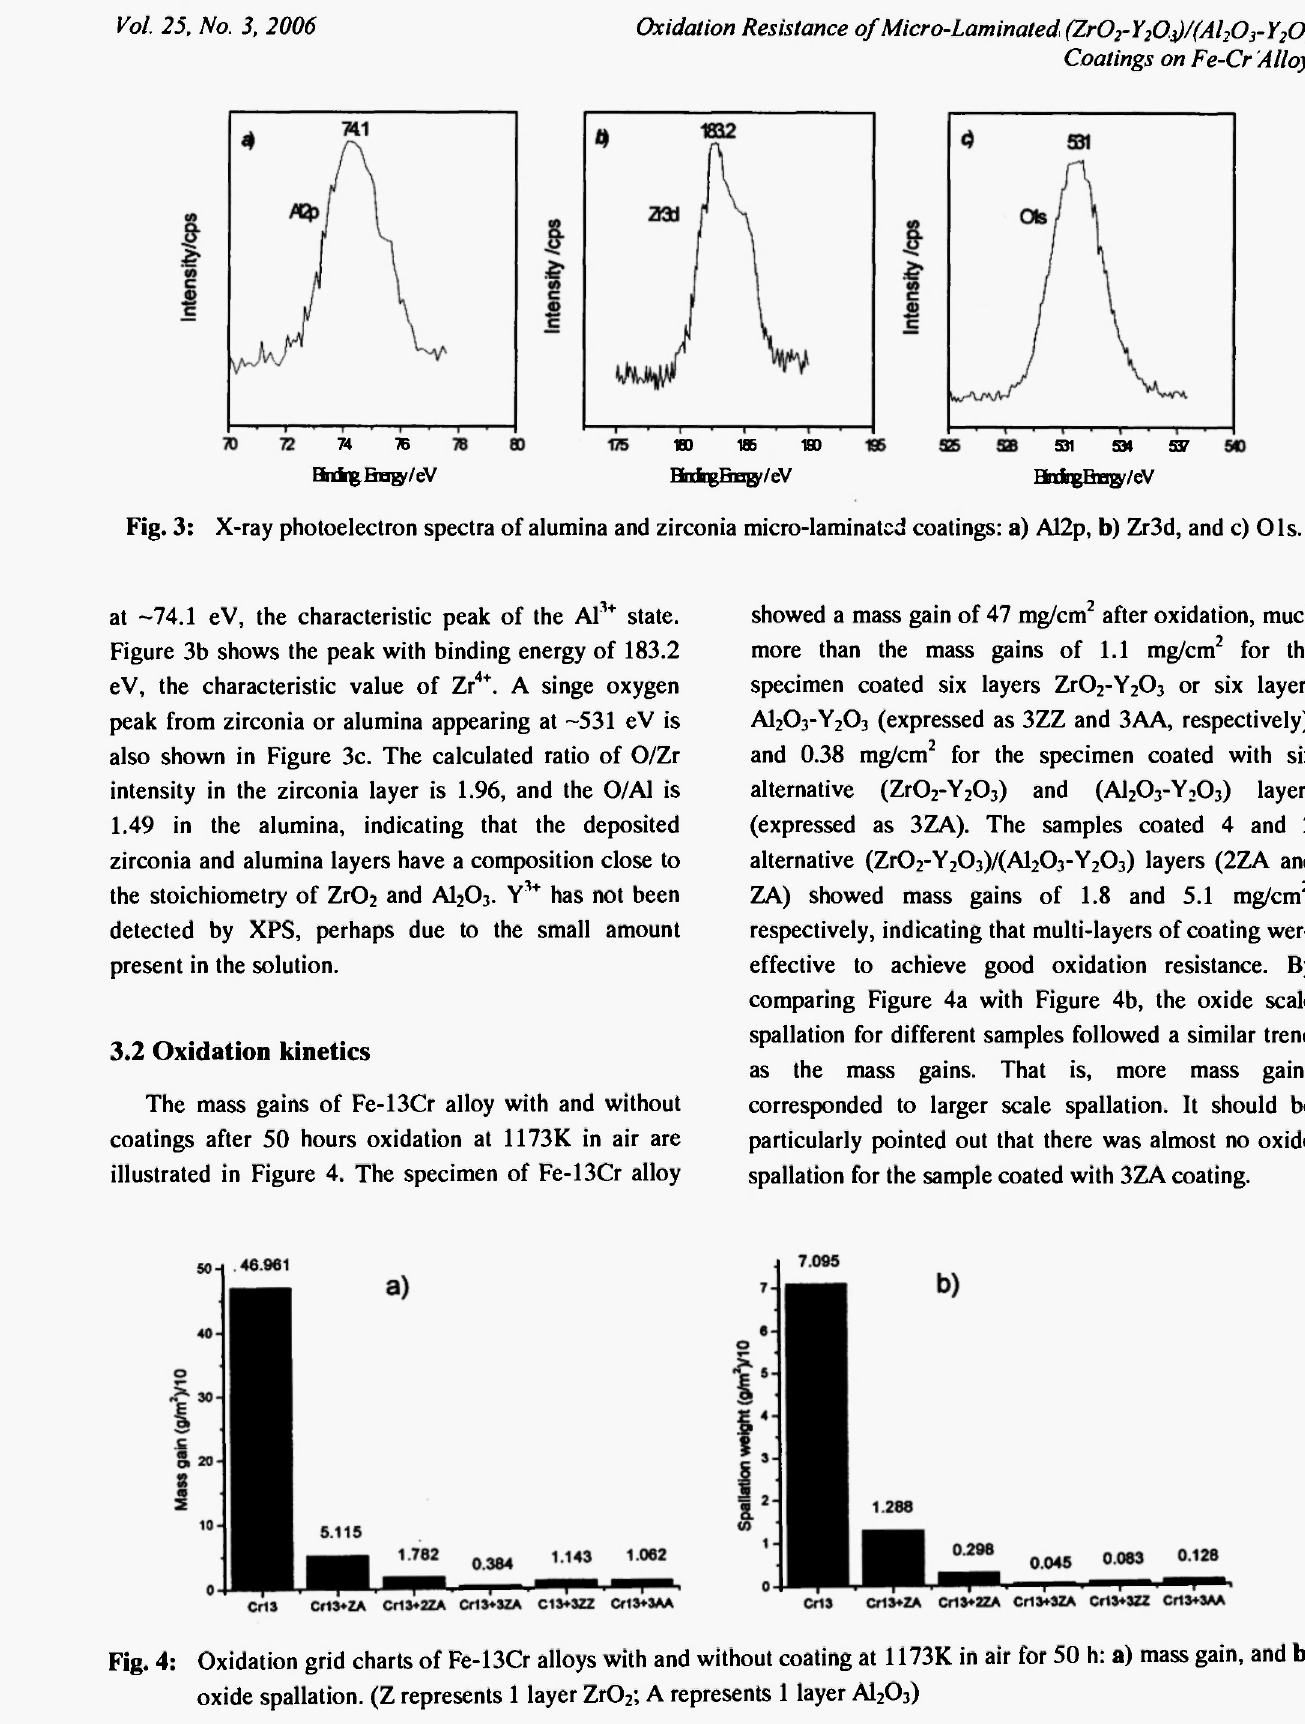
Fig. 4: Oxidation grid charts of Fe-13Cr alloys with and without coating at 1173K in air for 50 h: a) mass gain, and b) oxide spallation. (Z represents 1 layer Zr0